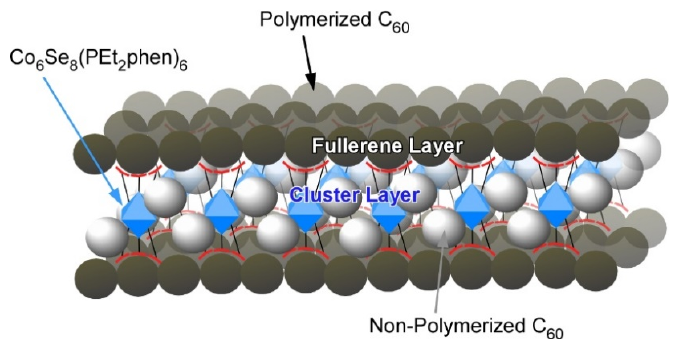
Figure 6. Isolated free ‐ standing two ‐ dimensional crystalline C 60 structure fabricated by photopoly ‐ merization and solvent ‐ induced exfoliation.